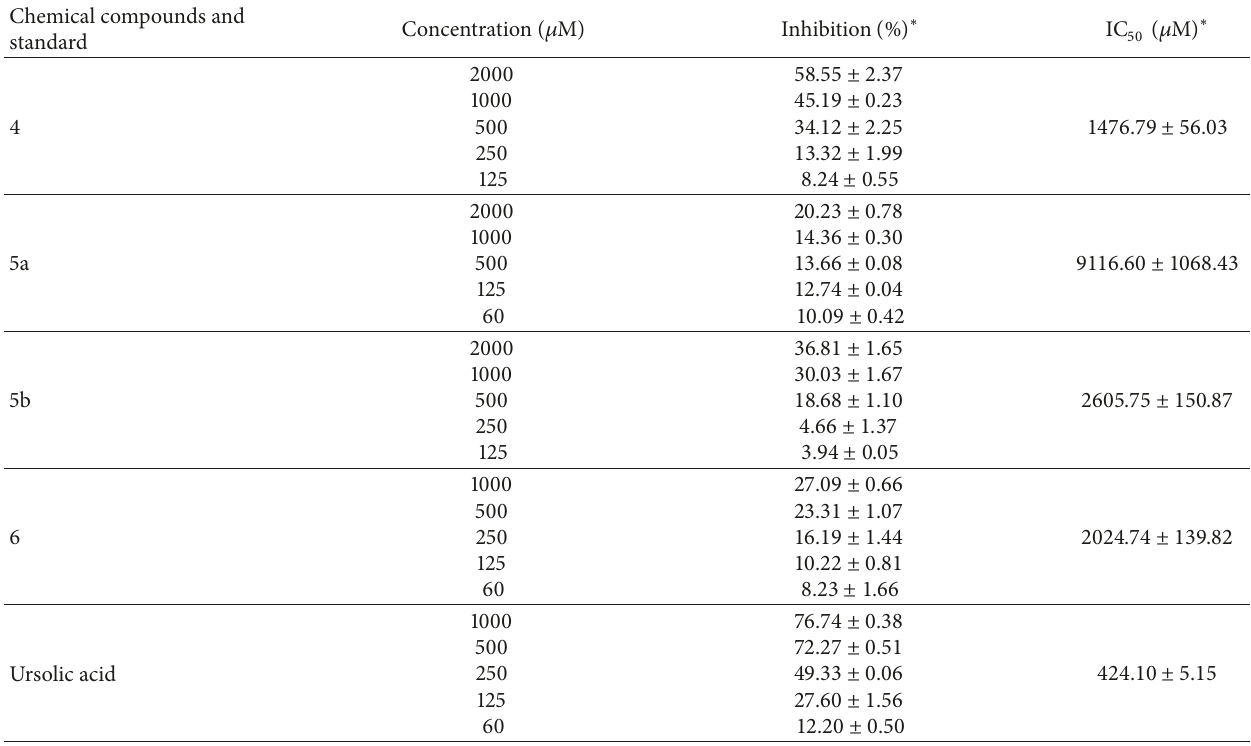
Table 3: The elastase inhibitory activity of different concentrations of S-substituted perhalonitrobuta-1,3-diene compounds. Chemical compounds and